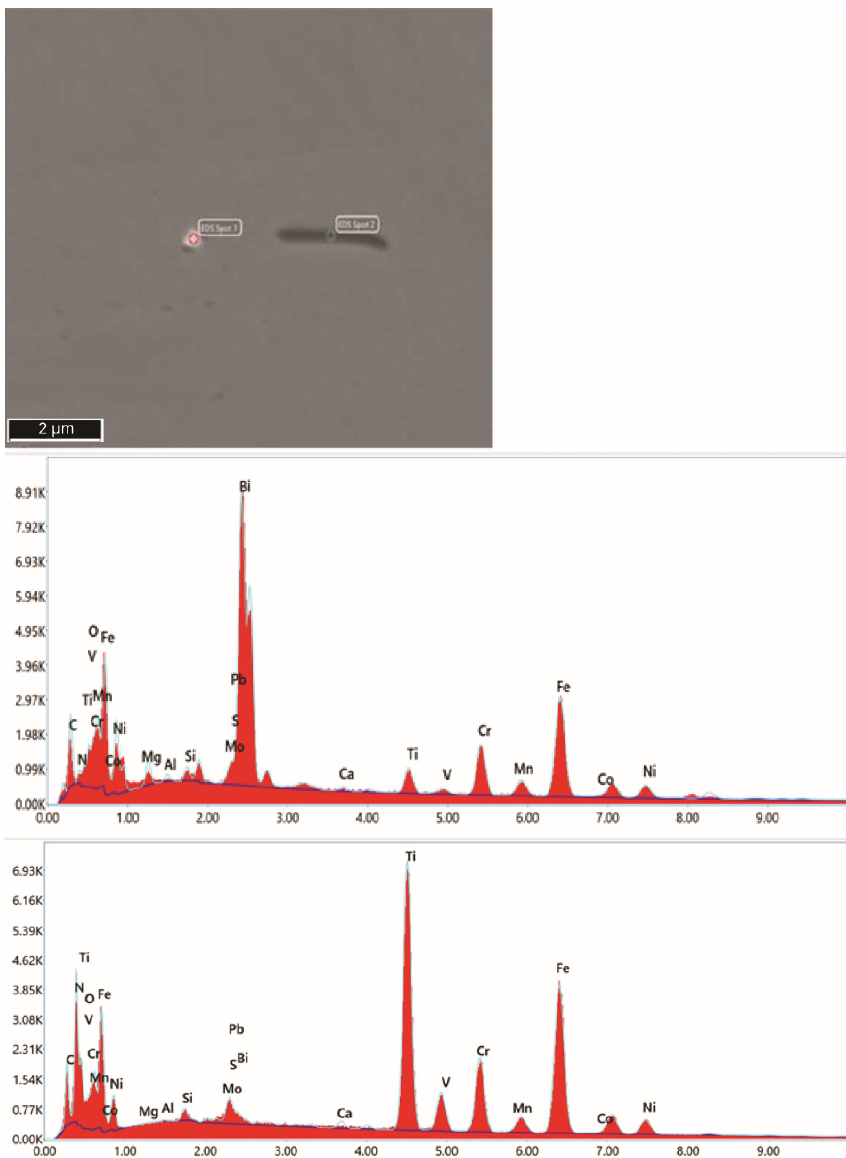
Figure 13. Bi and Pb enrichments in the hot-rolled plate of steel A (FE-SEM-EDS; mag. 10,000×).